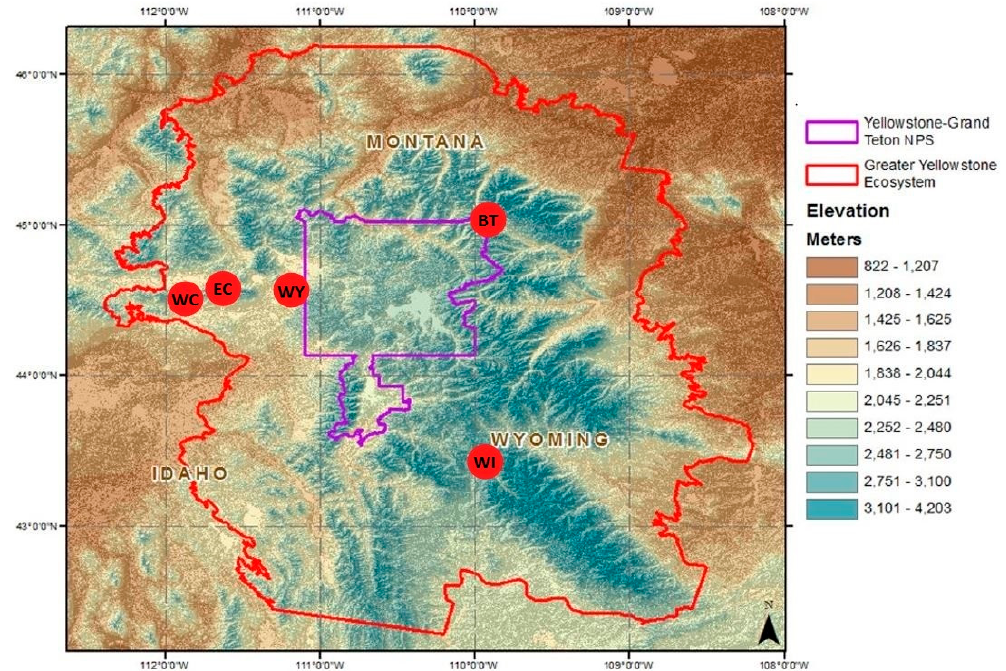
Figure 1. Greater Yellowstone Ecosystem with whitebark pine planting units (red dots with black two-letter planting unit abbreviations; BT = Beartooth, EC = East Centennial, WC = West Centennial, WI = Wind River, WY = West Yellowstone) and Yellowstone and Grand Teton national park boundaries (modified from Chang et al. 2014).